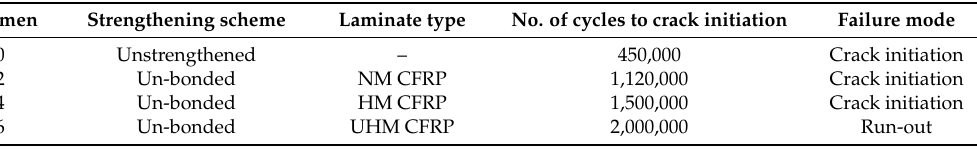
Table 6. Fatigue test matrix and results.